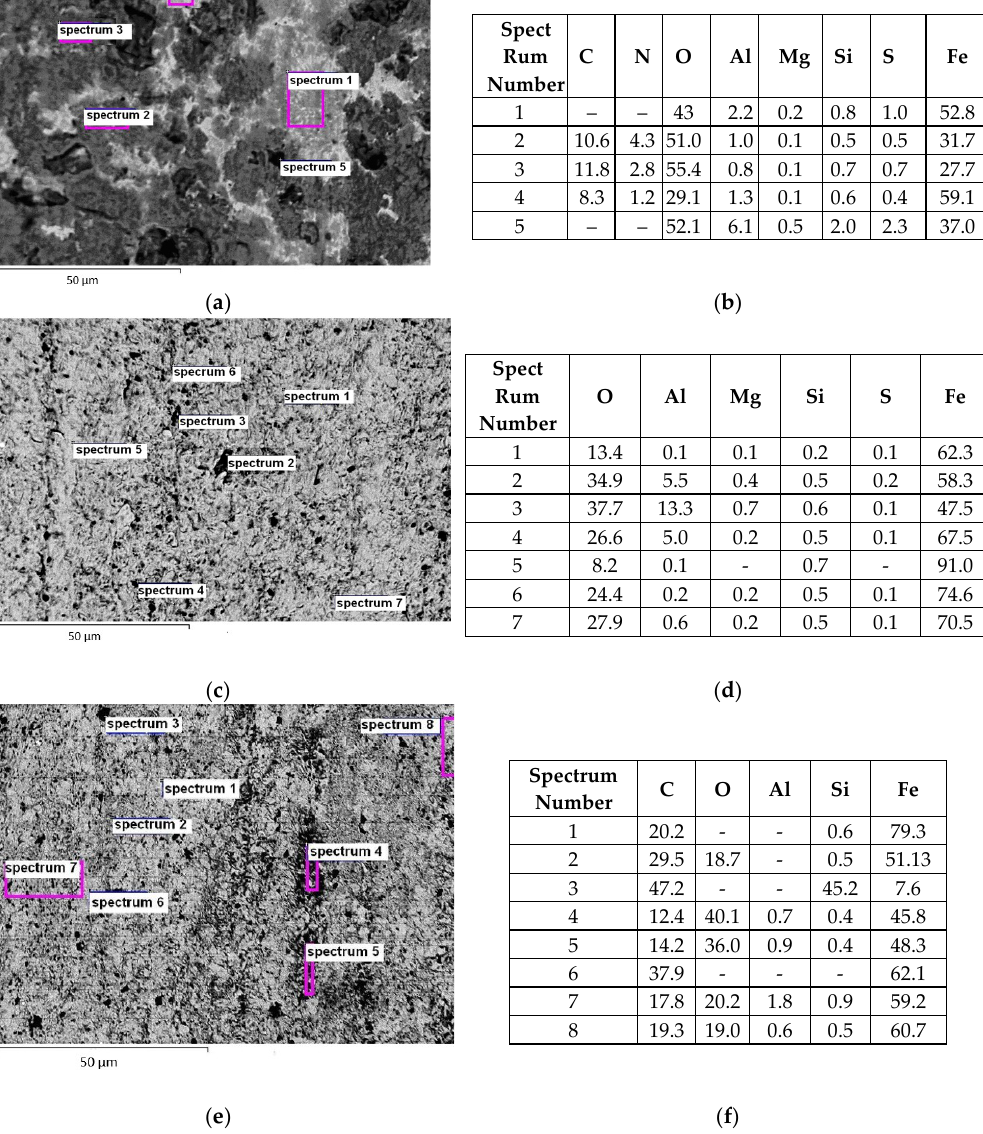
Figure 8. The structure of the friction surfaces ( a,c,e ) and the results of their microspectral analysis ( b,d,f ) with elemental composition (at. %) of the various regions of tribo-layers formed on the surfaces of specimens from the 45 ( a,b ) and U8 ( c–f ) steels after their electrolytic pre-hydrogenation (hydrogen of diffusion type) and after their subsequent wear test in tribo-pair with PEO layer synthesized on the AMg-6 in the pure mineral oil of the I-20 type ( a,b ) and with the addition of 0.5 vol. % water ( c,d ) or of 1.0 vol. % of an aqueous solution of glycerine ( e,f ) at the specific load in the friction zones of 4.0